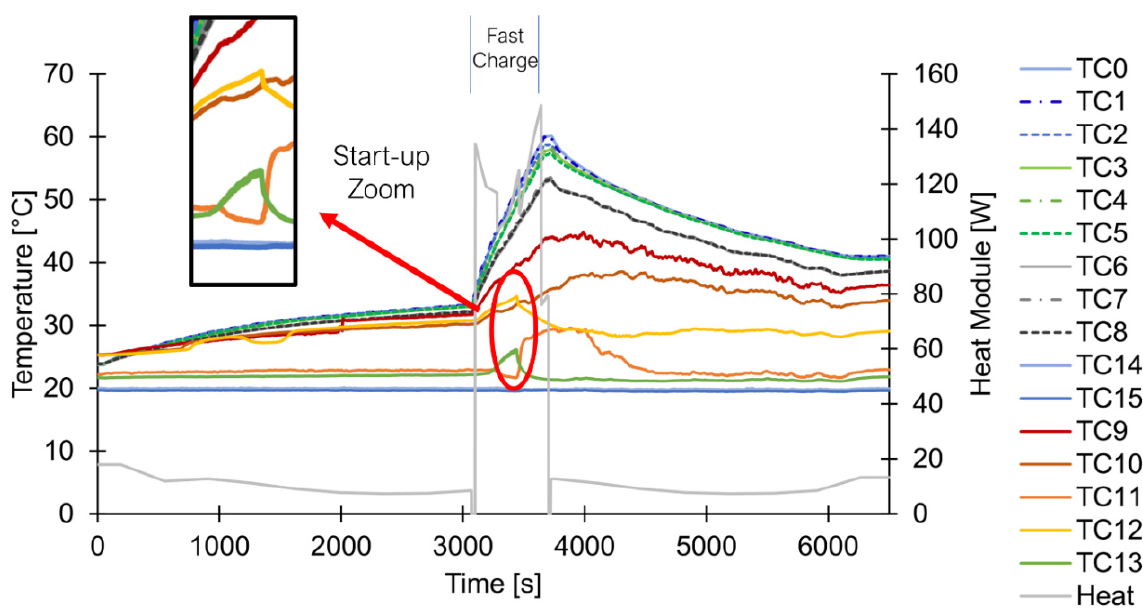
Figure 6. Test results during a HFCH driving cycle using Ethanol as working fluid.